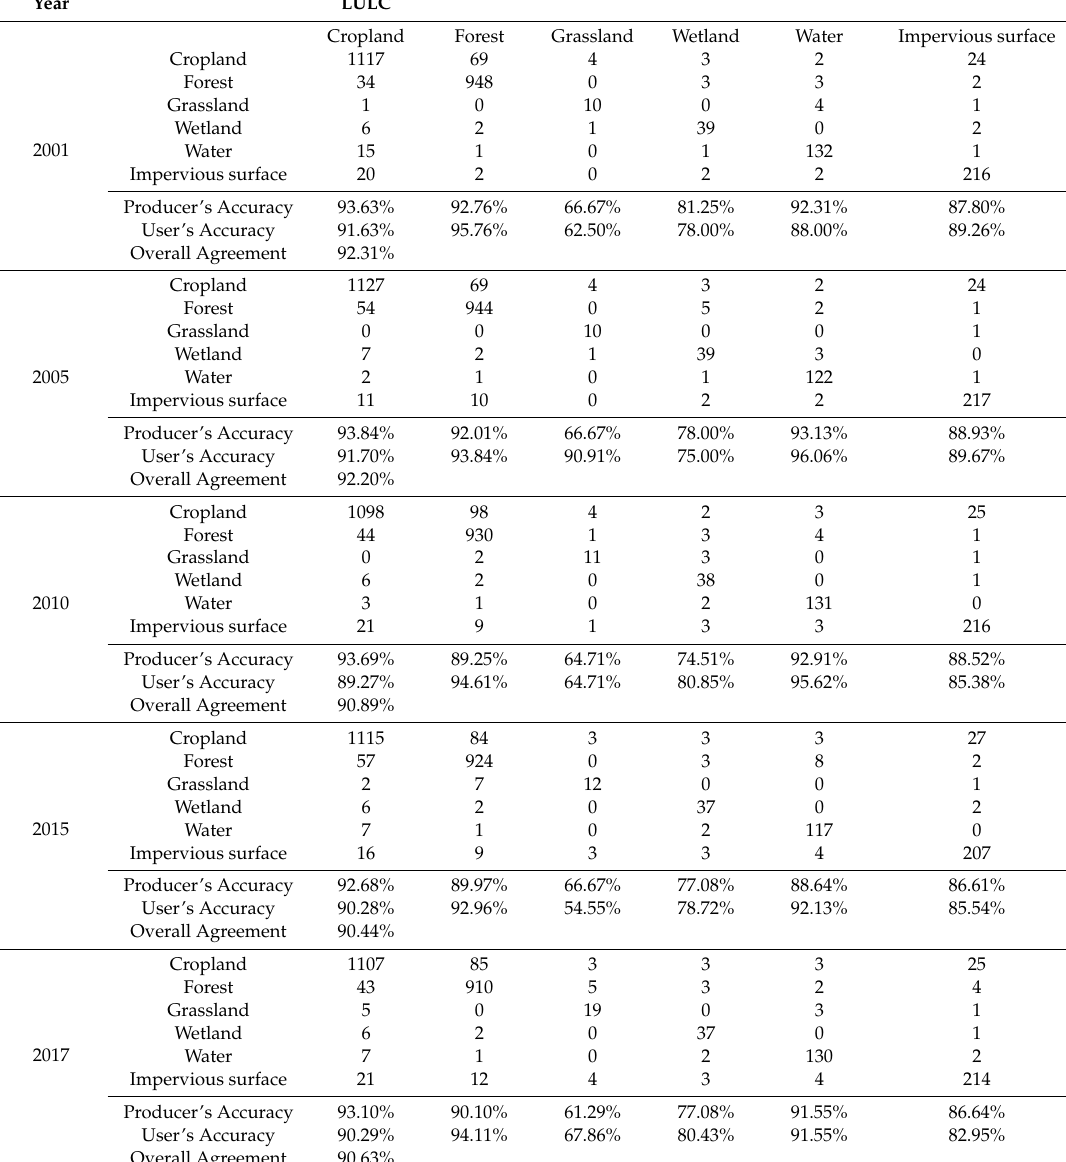
Table 2. Results of the spatiotemporal accuracy assessment for the